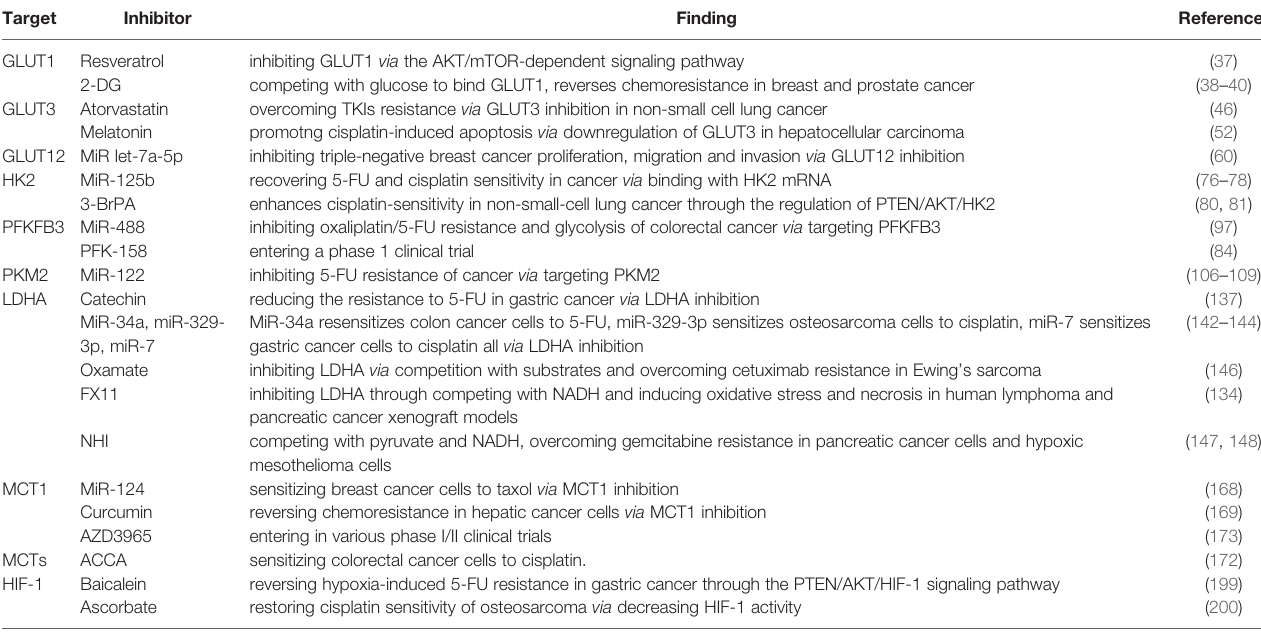
TABLE 1 | A list of glycolytic inhibitors targeting transporters, key enzymes, and signaling pathway in the glucose metabolic pathway. Target Inhibitor Finding